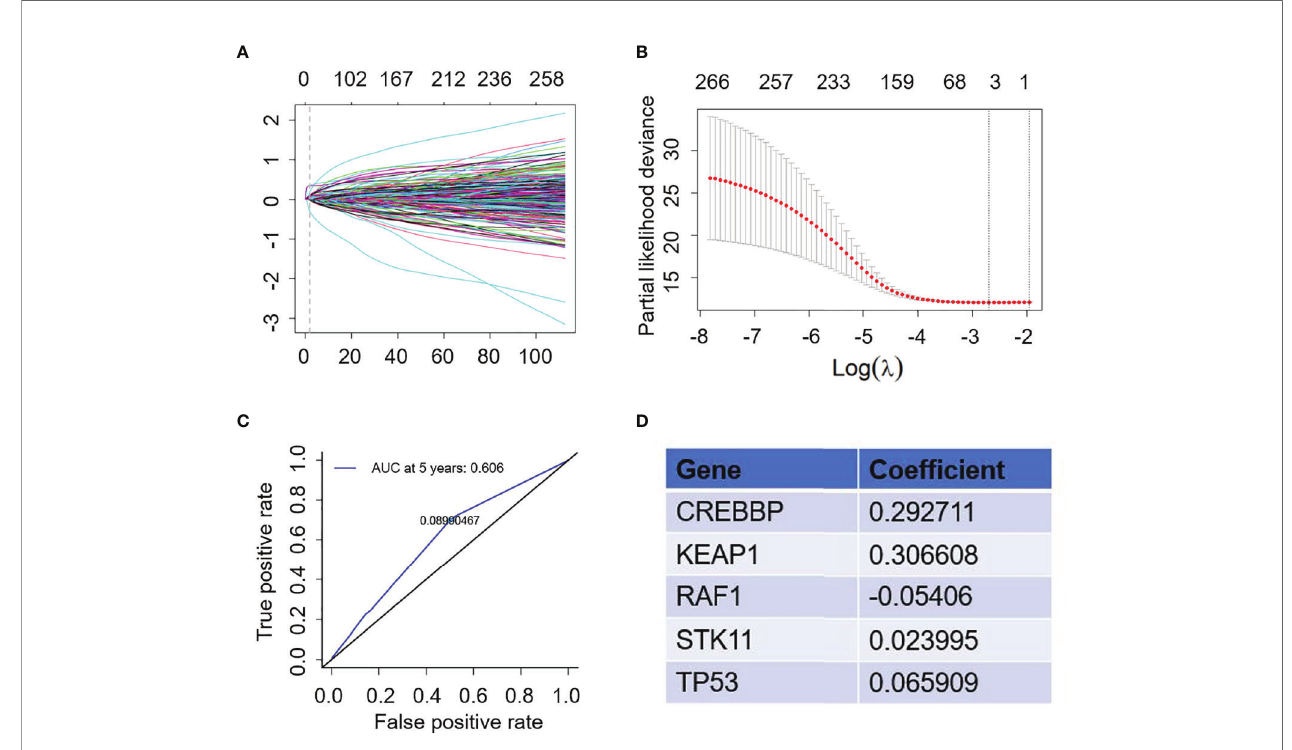
FIGURE 2 | Construction of gene mutation signature to predict survival. (A) Trend graph of LASSO coef fi cients. (B) Partial likelihood deviation map. (C) Time dependent ROC curve. (D) 5 gene mutation types and matched coef fi